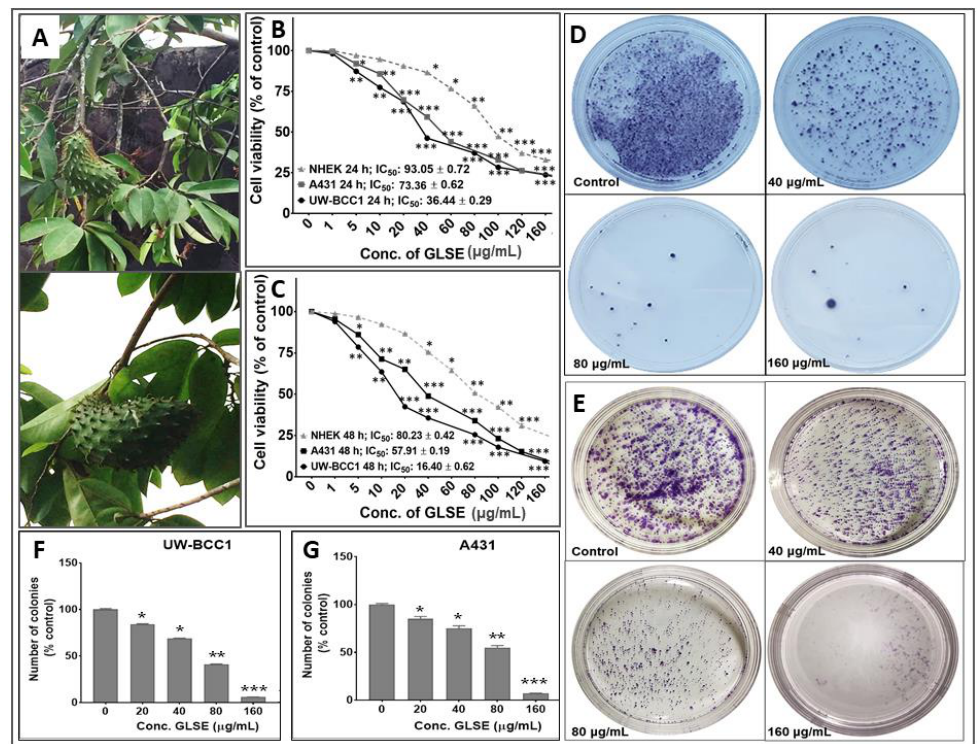
Figure 1. ( A ) Graviola aerial parts including leaves, stems and fruits. Effects of GLSE on UW-BCC1 and A431 cell viability after ( B ) 24 h or ( C ) 48 h and colony formation of non-melanoma skin cancer (NMSC) cells. Cells were incubated with the indicated concentration of GLSE, and percentage cell viabilities, determined by CCK-8 assay for UW-BCC1 cells, and by MTT assay for A431 and NHEK cells, were plotted against the doses of GLSE (μg/mL). Values used for plotting are means of experiments performed three times, with each concentration tested in 7–8 wells. Effects of GLSE on clonogenicity of UW-BCC1 ( D and F ) and A431 ( E and G ) cells as detected by colony formation assay. The purple color shows the density of stained cell colonies in the different treatment groups. Means for each cell line were compared against NHEKs in viability studies. Statistical differences from control cultures are shown as bar graphs with error bars representing the means ± SD in panels ( F ) and ( G ); * p < 0.05 and ** p < 0.01 and *** p < 0.001 vs. control (DMSO-treated) cells.